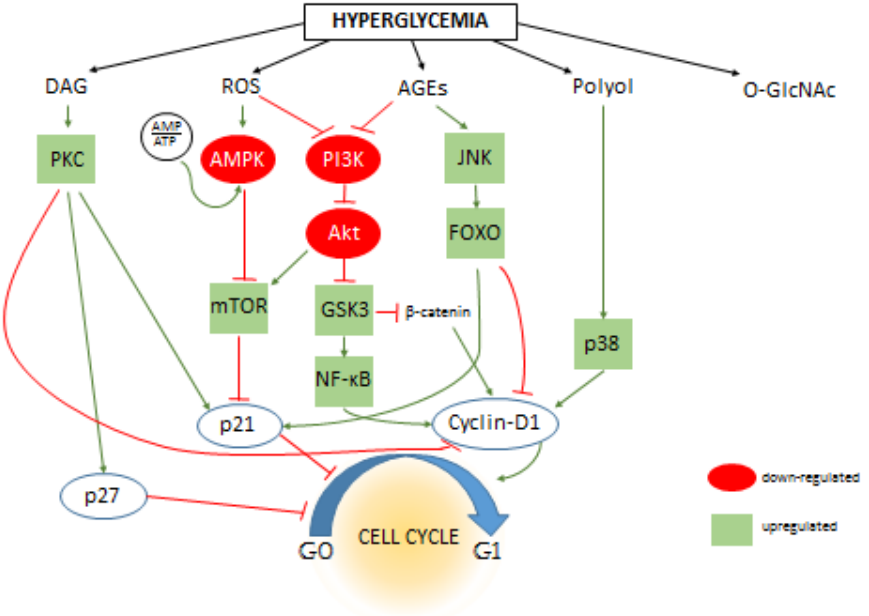
Figure 1. The effect of hyperglycemia on intracellular signaling pathways and cell cycle regulation. The primary metabolic changes caused by excess amount of intracellular are increased levels of diacyl-glycerol (DAG), reactive oxygen species (ROS), advanced end-glycation products (AGEs), sorbitol (Polyol), and protein O-Glycosylation (O-GlcNAc). Dozens of secondary messengers and signaling elements are activated (or de-activated) that are connected to the cell cycle regulatory system and eventually influencing cell proliferation by either directly influencing cyclins, cyclin-dependents kinases and cell cycle inhibitors such as p21 or altering their expression level through influencing transcriptional activity. The figure shows some of these connections; positive or negative effects inherent to the interactions are indicated by green or red lines between proteins, respectively. The effect of hyperglycemia (if it is known) on the activity of individual signaling elements are indicated by green (up-regulation) or red (down-regulation) background coloring. For clarity, the connections of O-GlcNAc are omitted from this figure, however please note that increasing number of evidences suggest that the majority of intracellular signaling elements are modified and influenced by O-GlcNAc modification.